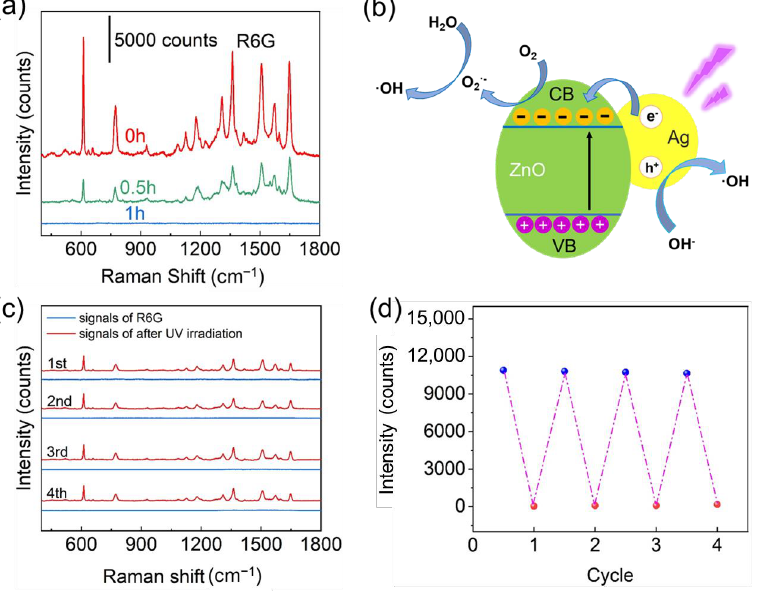
Figure 5. ( a ) SERS spectra of R6G (10 − 7 M) obtained from the Ag/ZnO NR arrays after adsorbing R6G molecules and subsequent exposure to UV light for 0, 0.5 h, and 1 h. ( b ) Mechanistic diagram of photocatalytic degradation for the Ag/ZnO hybrid nanomaterial. ( c ) SERS spectra collected from a 10 −7 M R6G loaded SERS substrate before and after subsequent photocatalytic degradation. ( d ) Intensity of 612 cm −1 peak (10 −7 M R6G) in 4 cycles.